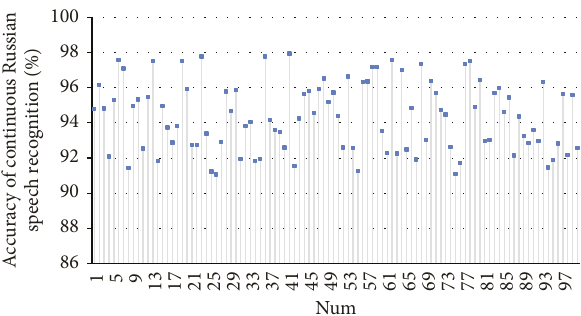
Figure 10: System framework.